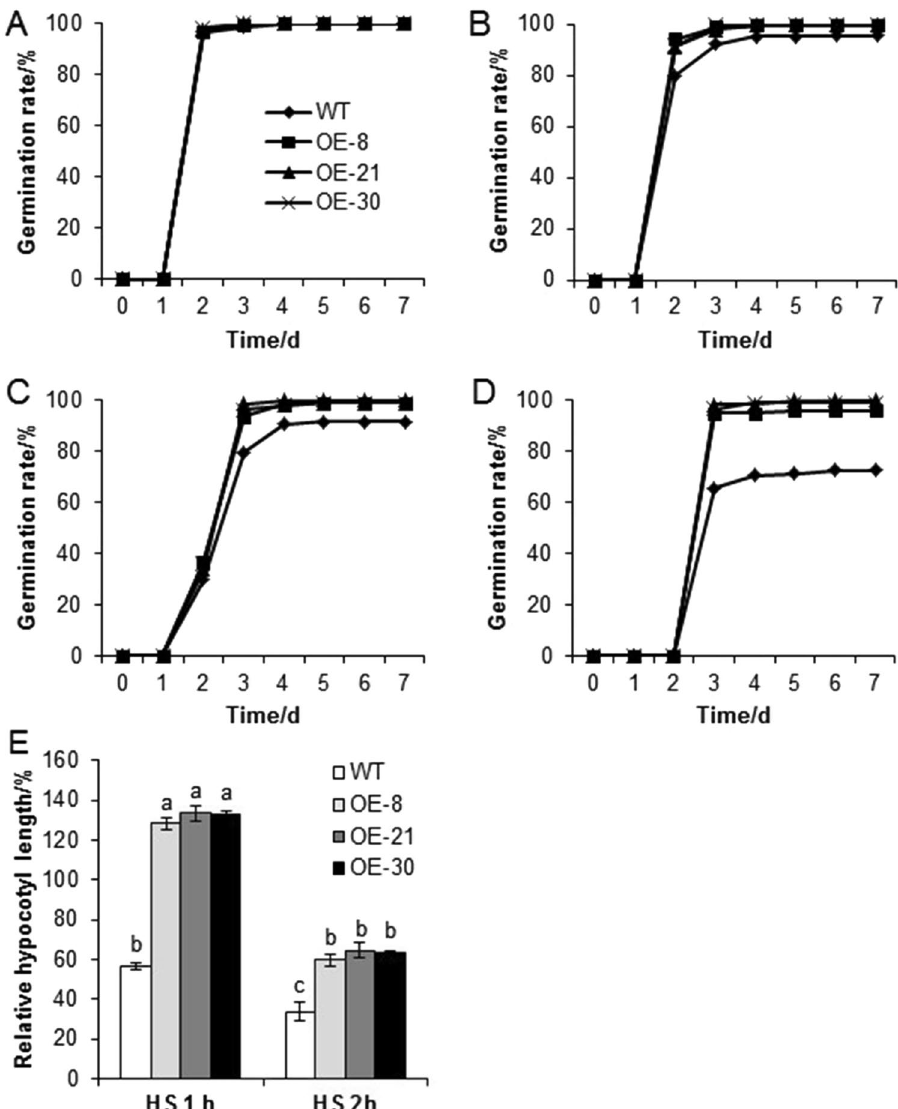
Figure 7. Germination rates ( A – D ) and relative hypocotyl lengths ( E ) of WT and transgenic A. thaliana under HS. ( A ) Control group, ( B ) HS for 1 h, ( C ) HS for 2 h, and ( D ) HS for 3 h. Error bars represent standard deviations and are based on data for at least 10 seedlings from each line. Significant differences between WT and transgenic plants are indicated by different letters ( P <